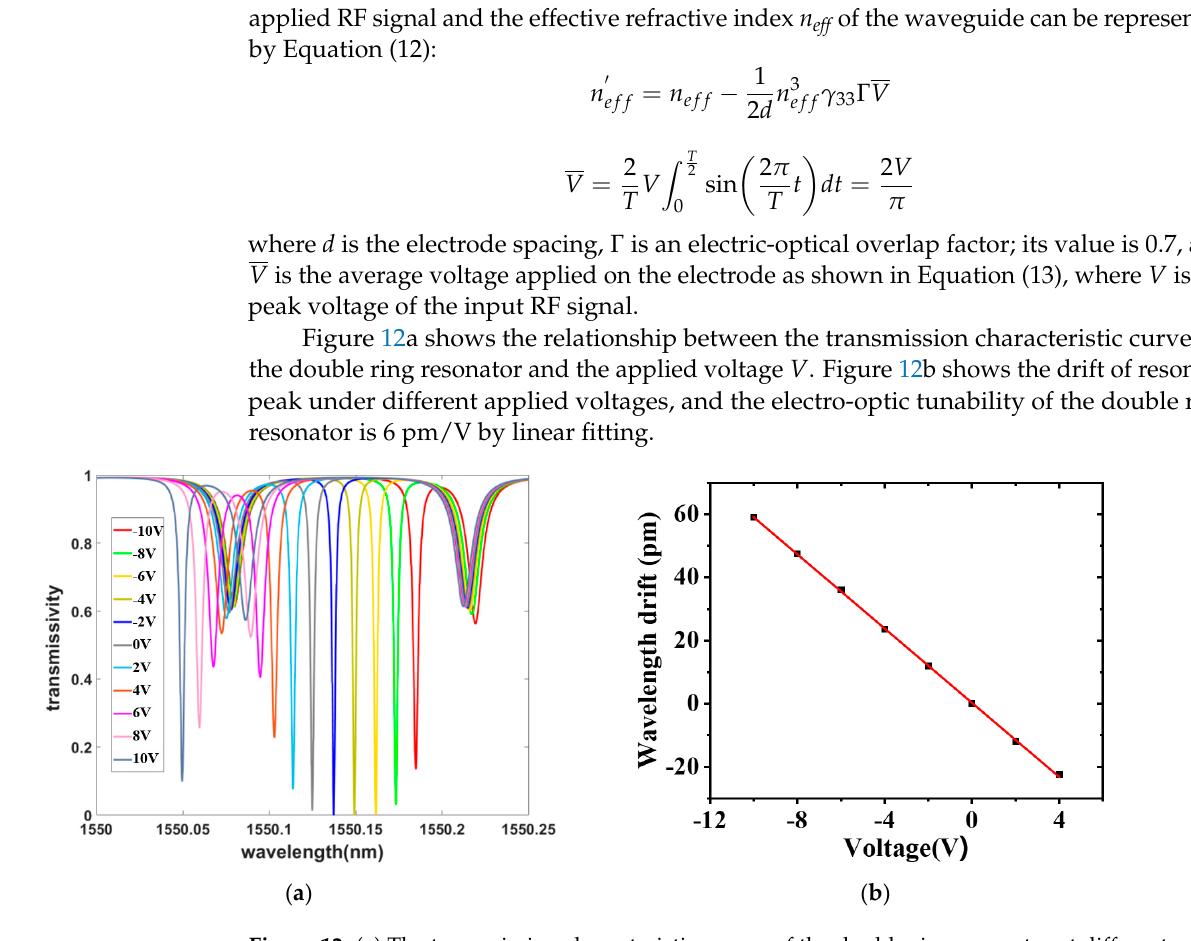
Figure 12. ( a ) The transmission characteristic curves of the double ring resonator at di ff erent wavelengths and applied RF signals and ( b ) the wavelength drift at di ff erent applied RF signals.